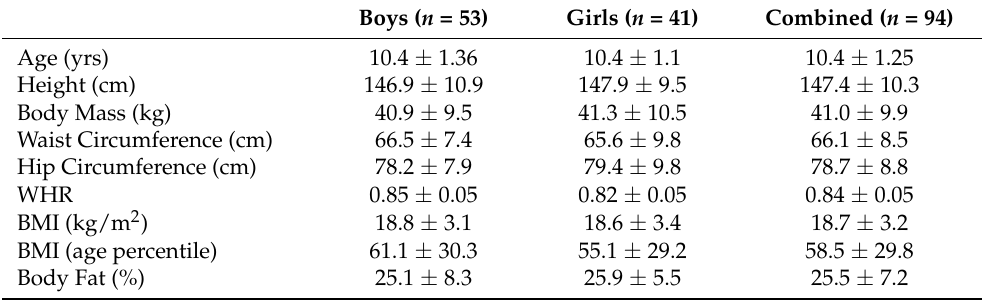
Table 1. Participant Characteristics.